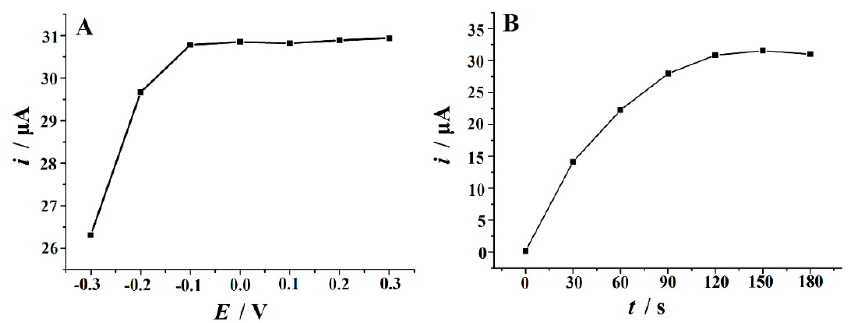
Figure 7. ( A ) The effect of accumulation potential and ( B ) accumulation time on the peak current of 10 μ M Trp in 0.05M H 2 SO 4 solution on the Cu 2 O ‒ ERGO/GCE at a scan rate of 100 mV s − 1 .